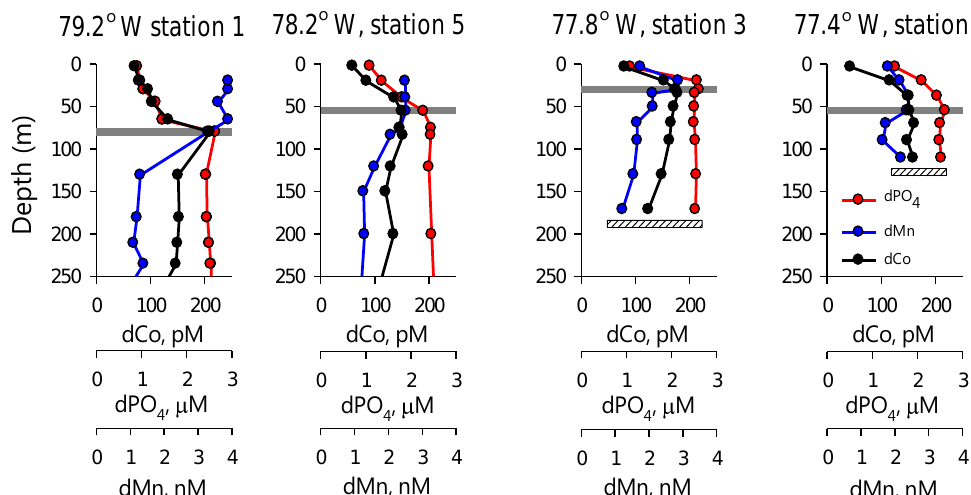
Figure 10. Profiles of dissolved cobalt (dCo, black), PO 4 (red), and dMn (blue) over the Peru shelf at 12 ◦ S. The oxycline (grey bar, defined by the first sample where O 2 <10µM) marks the transition between the OMZ and oxygenated surface waters. Station 2 is the closest to the coast. Note the similarity between dCo and PO 4 above the oxycline and the transition to a dMn-like profile beneath. Table 2. Co / Al ratios in sediments from different redox